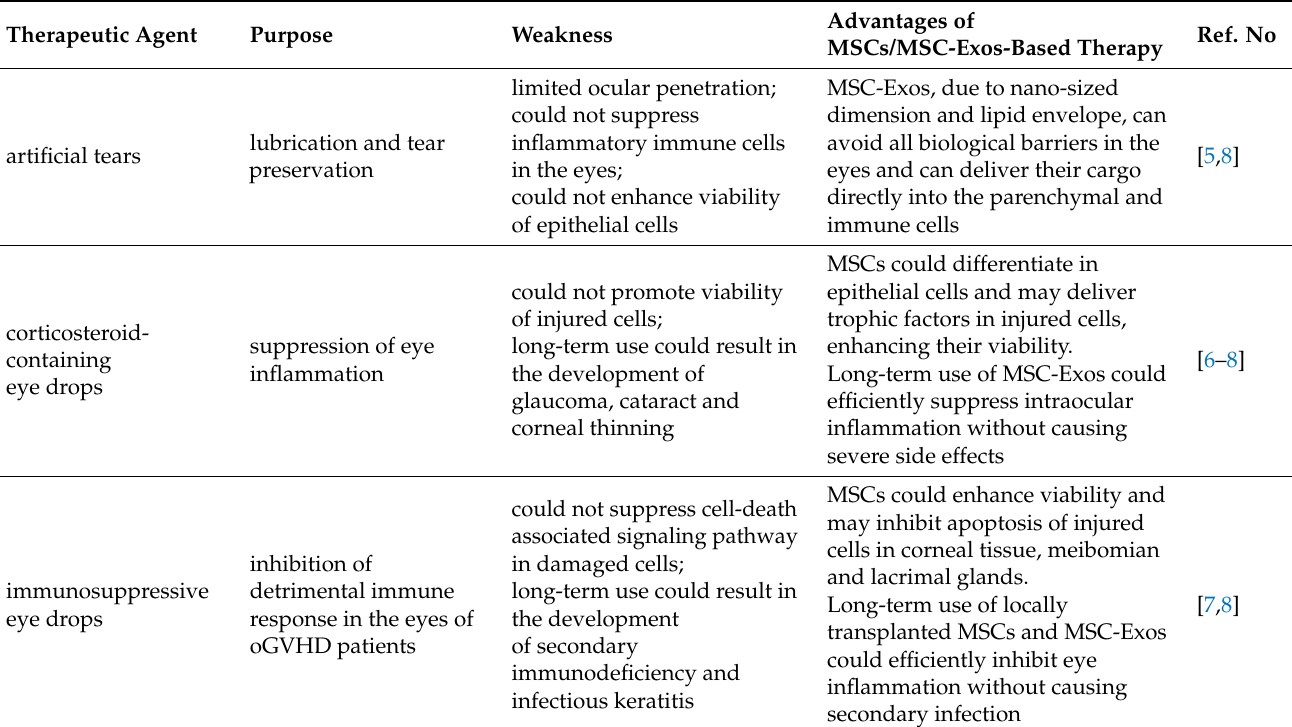
Table 1. The main purpose and weakness of currently used therapeutic agents in the oGVHD treatment and advantages of MSCs/MSC-Exos-based